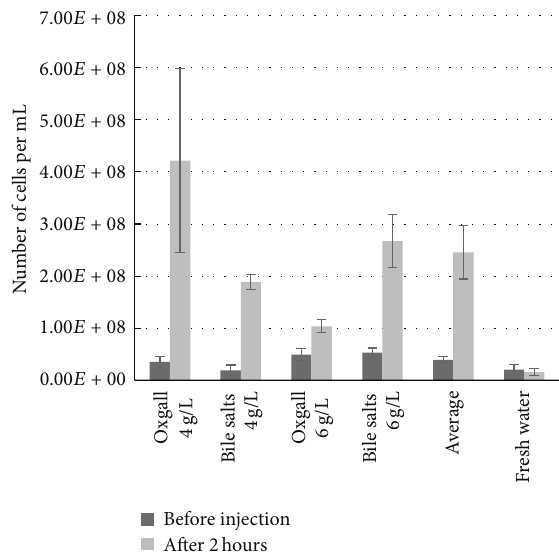
Figure 3: Acanthaster planci. Coelomic fluid cell counts per treat-